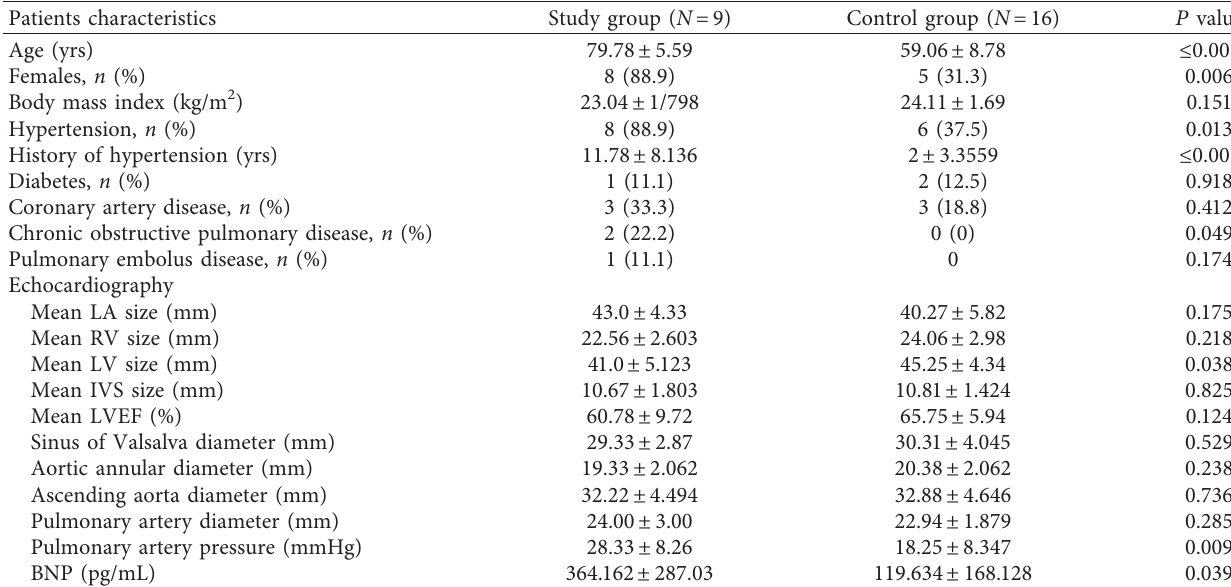
Table 1: Patient characteristics.